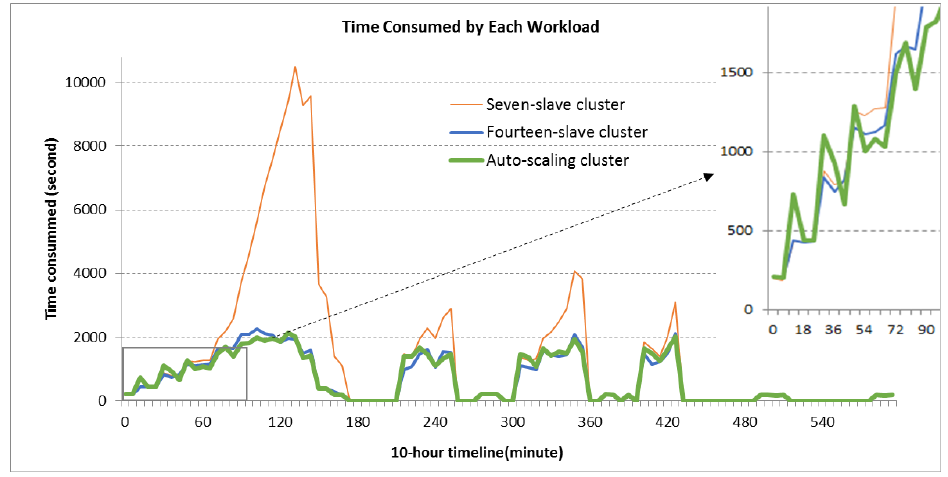
Figure 5. Time consumed by each workload (100 workloads in total) for the three clusters in the 10-hour period. The small diagram on the top-right corner is the zoomed-in view for the first 1.5 hours.